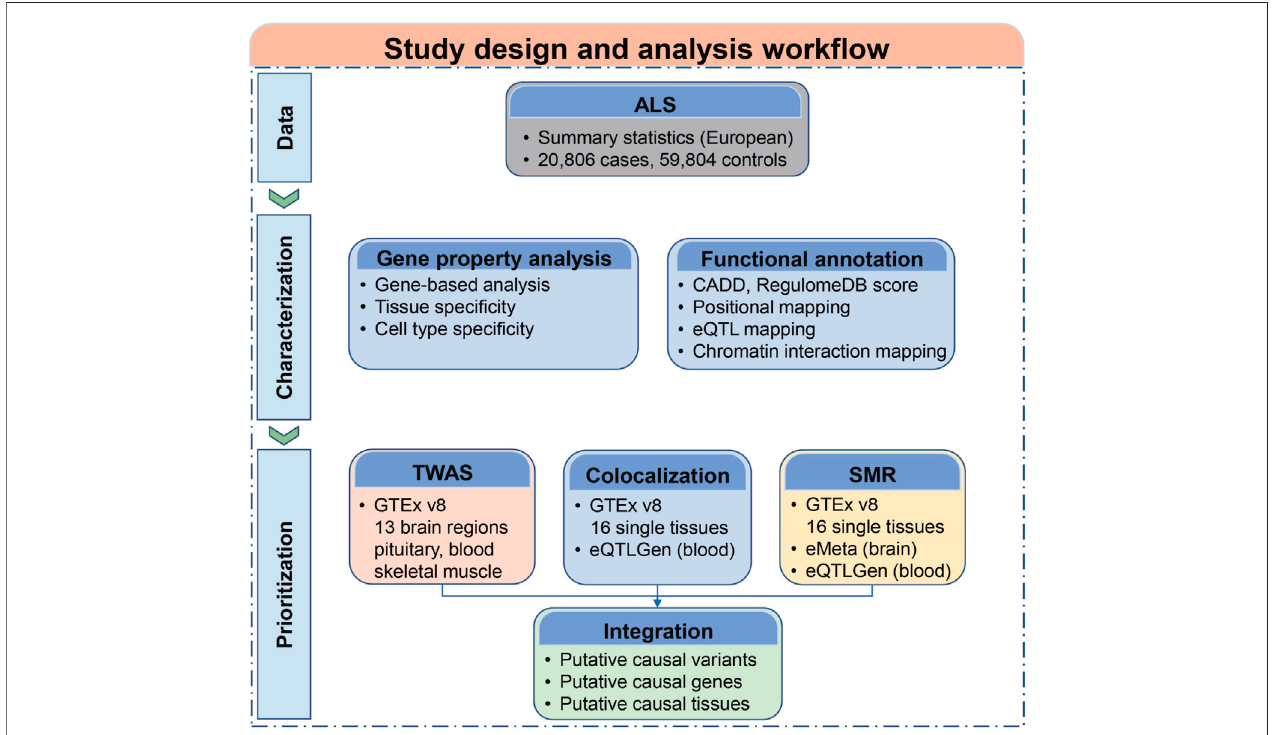
FIGURE 1 | Schematic overview of the study design. Data, data collection and preprocessing. Characterization, characterizing ALS risk loci, including gene property analysis and functional annotation. Prioritization, putative causal genes prioritization and summarizing the evidence.